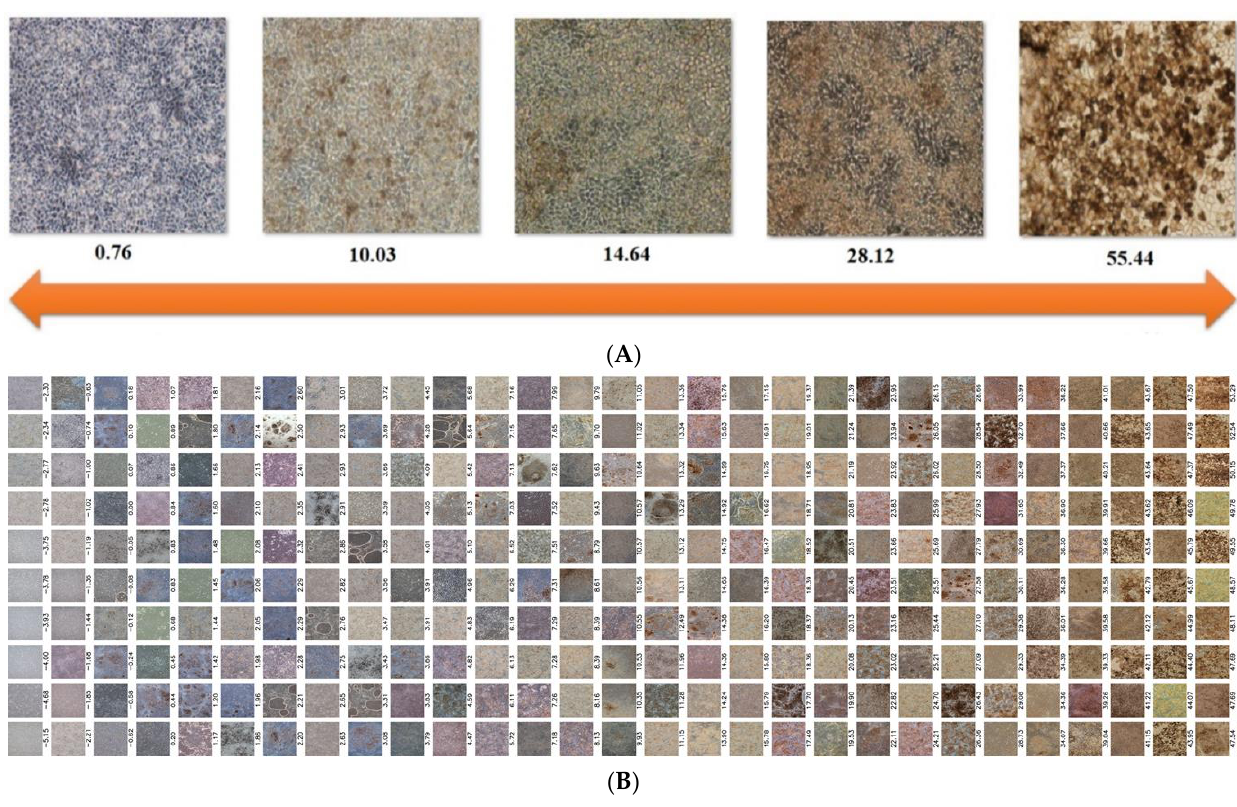
Figure 8. Evaluation of the RPE differentiation degree by the value of the PCA projection. ( A ) From left to right, the larger value reflects higher differentiation degree of iPSC-RPEs. ( B ) Sorting the values of projections of iPSC-RPEs. From left to right: the larger value reflects higher differentiation degree of iPSC-RPEs.